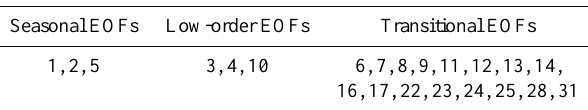
Table 3. EOF classification according to their dynamical index be-